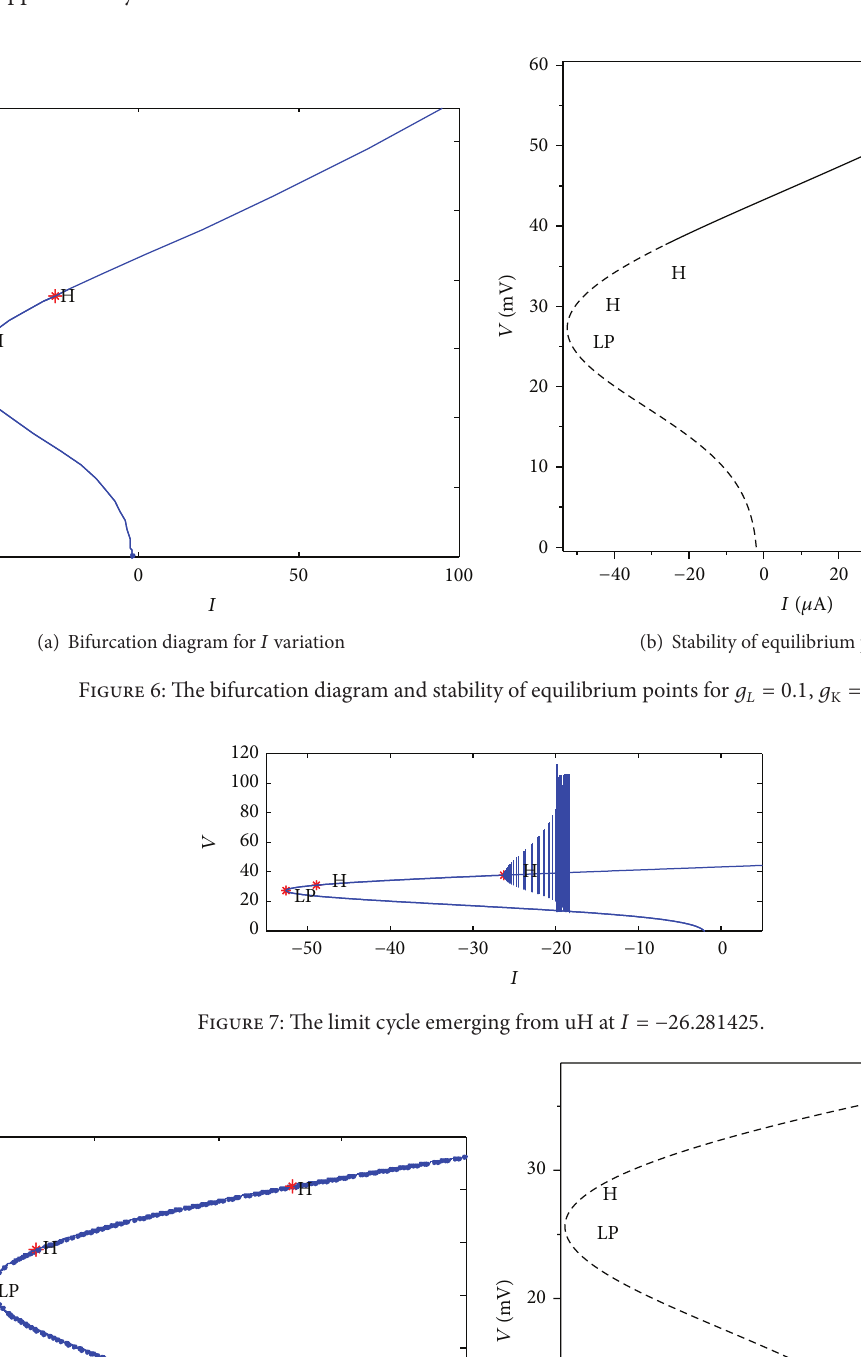
Figure 8: The bifurcation diagram and stability of equilibrium for 𝑔 𝐿 = 1 , 𝑔